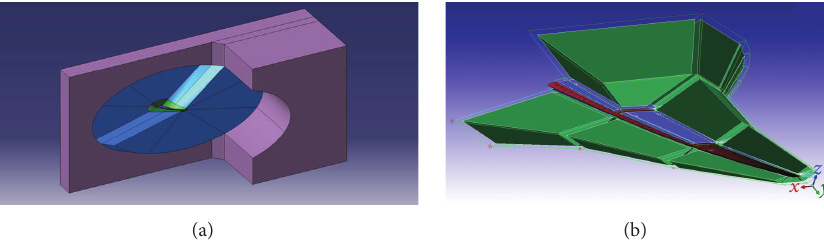
Figure 3: (a) Block layout around the curved wing model (partial view). (b) Block layout near the curved wing model (partial view).